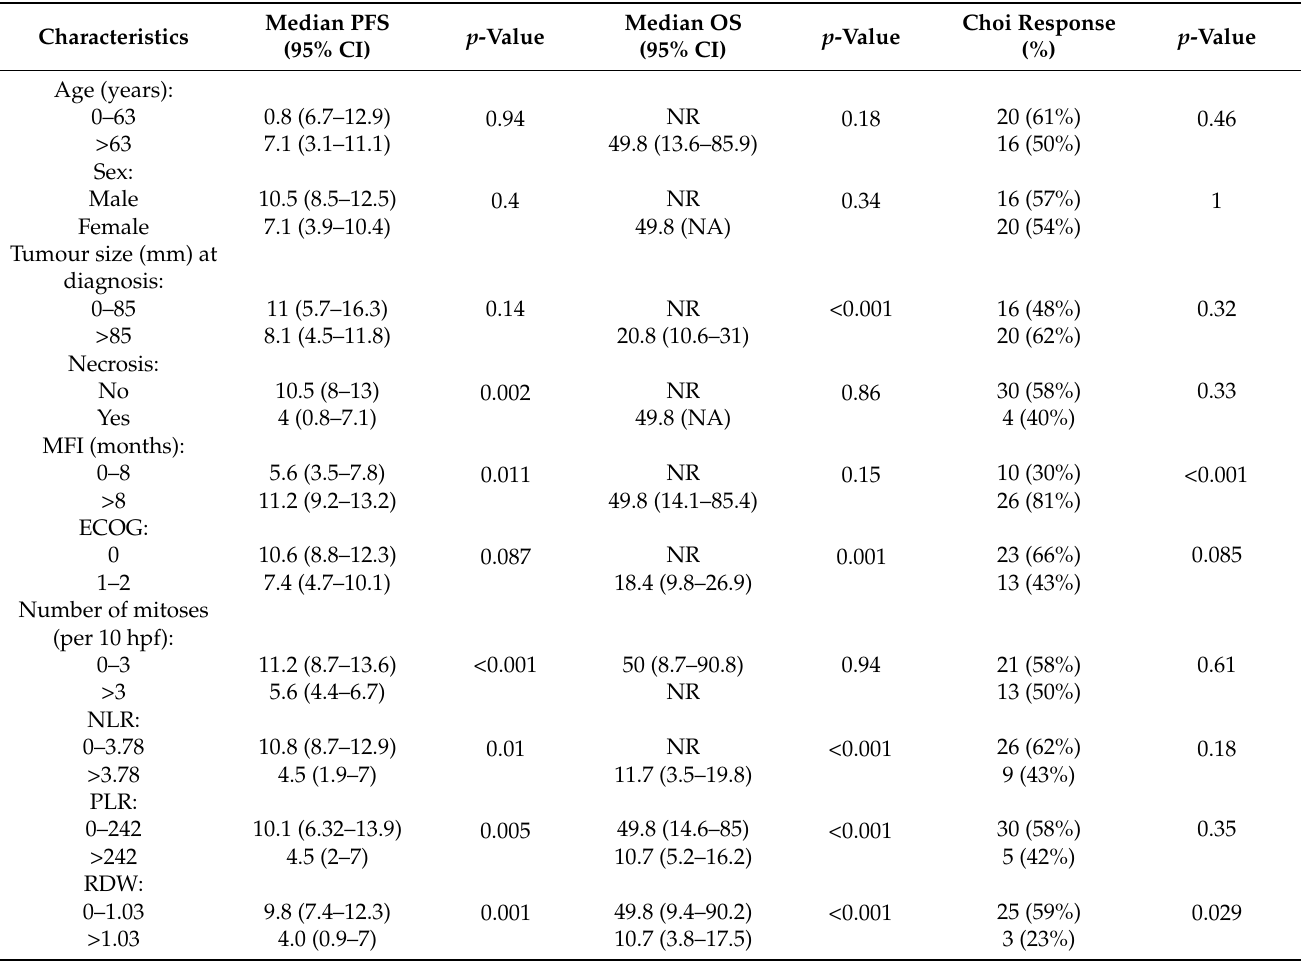
Table 2. Univariate analysis of clinicopathological factors and inflammatory indexes according to progression-free survival (PFS), overall survival (OS), and Choi